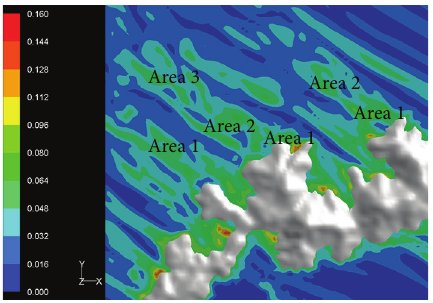
Figure8: Vorticity plotforthemodel simulationresult at31 minutes (magnitude of vorticity is in s −1